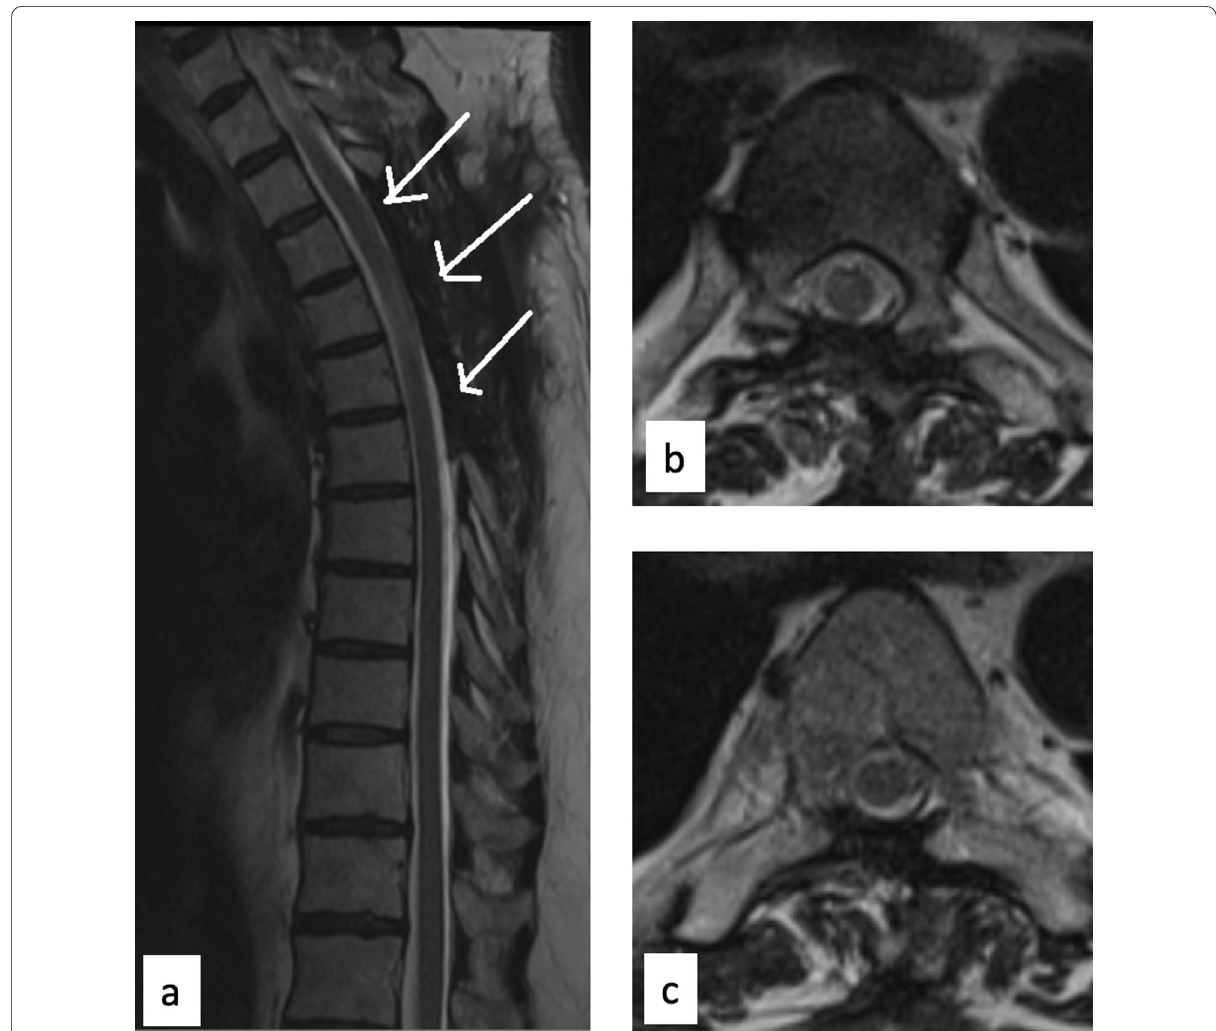
Fig. 3 Repeat MRI of the dorsal spine T2Wsagittal ( a ) and axial ( b , c ) 5 months later depicting resolution of the intramedullary signal abnormality and indentation of the cord seen previously in Fig.